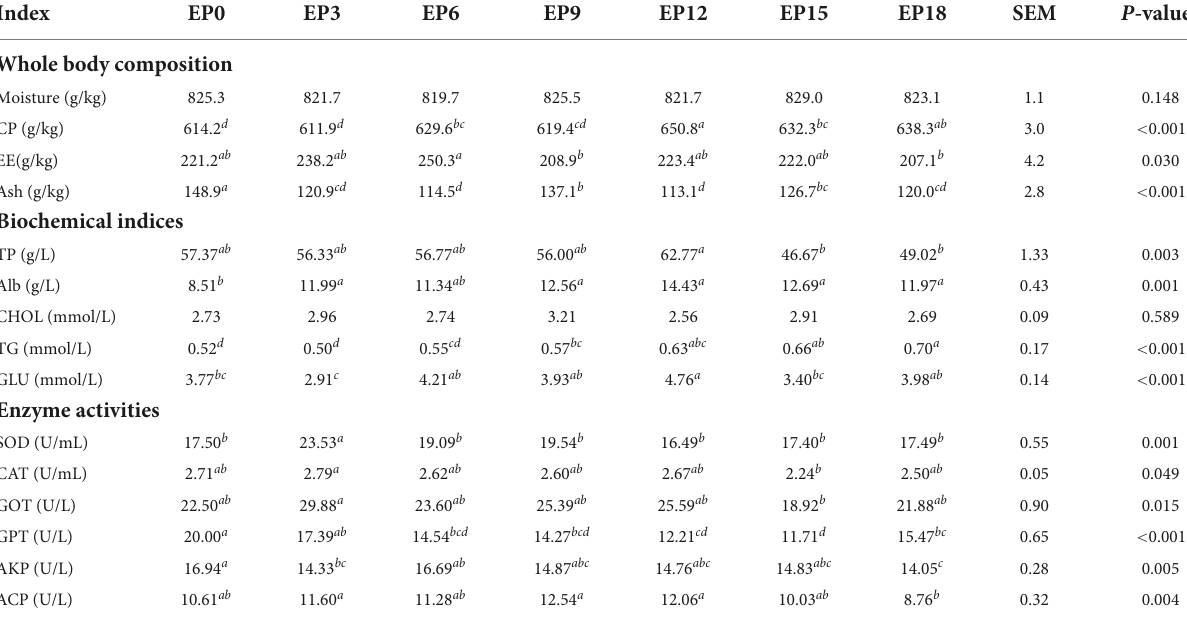
TABLE 4 Whole-body composition, serum biochemical indices, and enzyme activities of hybrid groupers fed with diets.